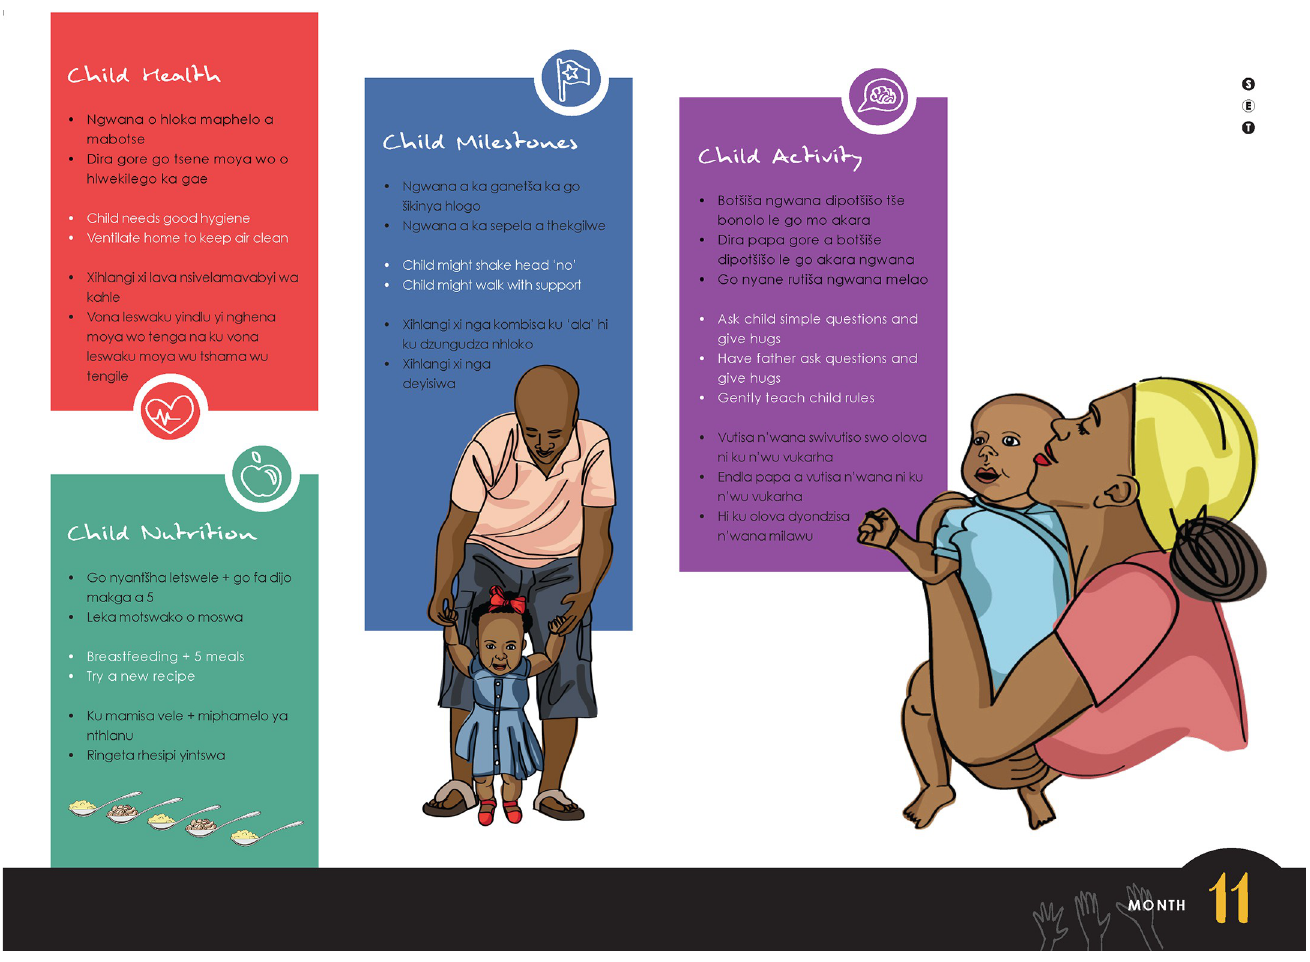
Fig 1. Example page from the CHW job